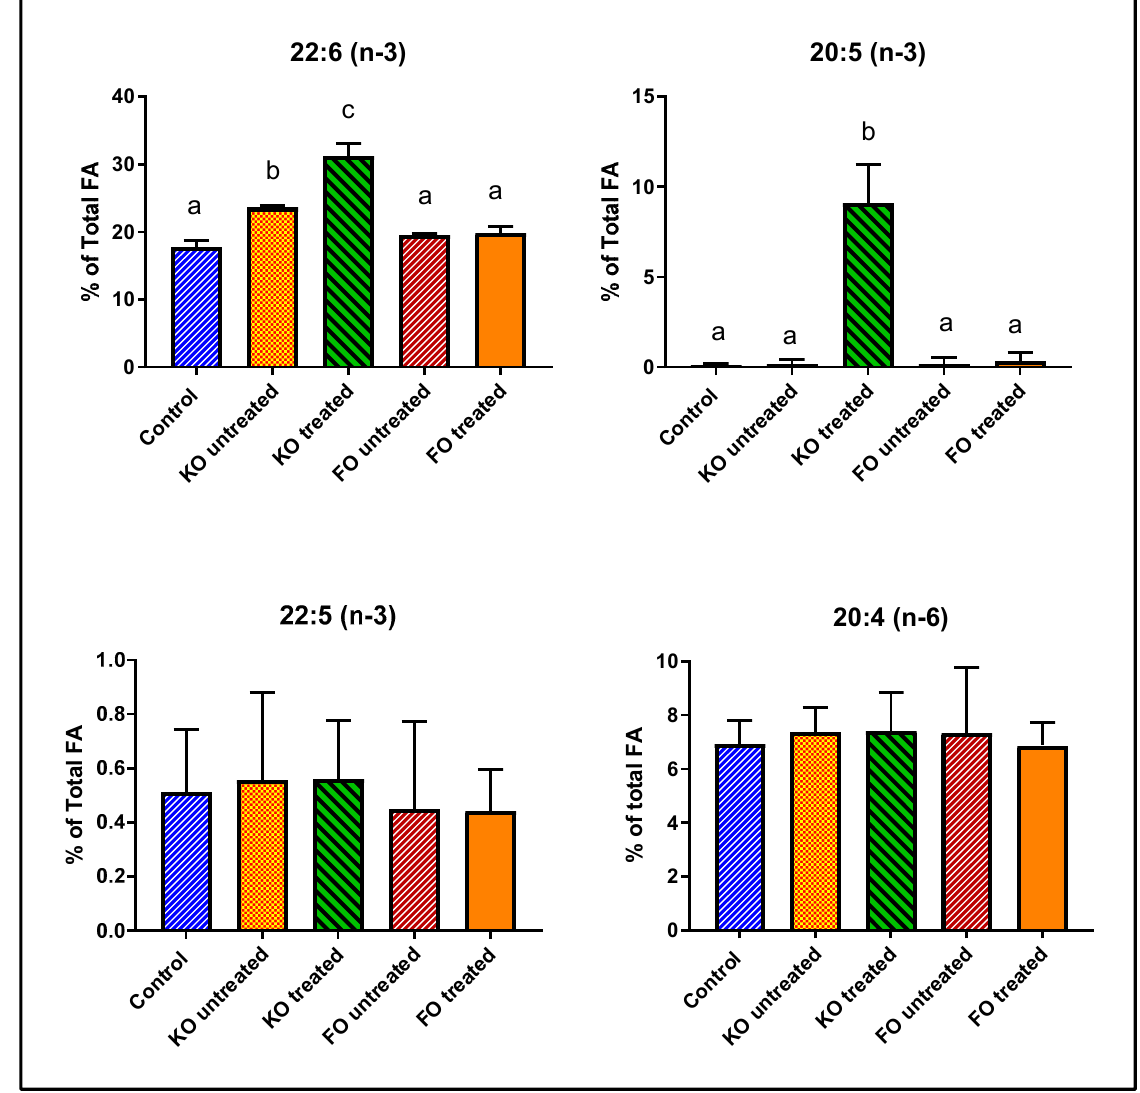
Figure 4. Effect of feeding untreated or lipase-treated fish oil and krill oil on mouse retinal FA. Normal male mice (8-week-old) were fed diets (AIN93G) containing 7% total fat and supplemented with 0.264% EPA+DHA in the form of fish oil or krill oil, which have been treated (or not) with Mucor lipase. The mice were fed the diets ad lib for 30 days and the retinal FA were analyzed by GC/MS. The percentages of 20:4 (n-6), 20:5 (n-3), 22:5 (n-3) and 22:6 (n-3) are shown here (mean ± SD, 5 mice/group. The total FA composition is shown in Table 3. Bars without common superscripts are significantly different from each other by a one-way ANOVA and Tukey post-hoc analysis. KO: krill oil; FO: fish oil; FA: fatty acid; EPA: eicosapentaenoic acid; GC/MS: gas chromatography/mass spectroscopy; DHA: docosahexaenoic acid.